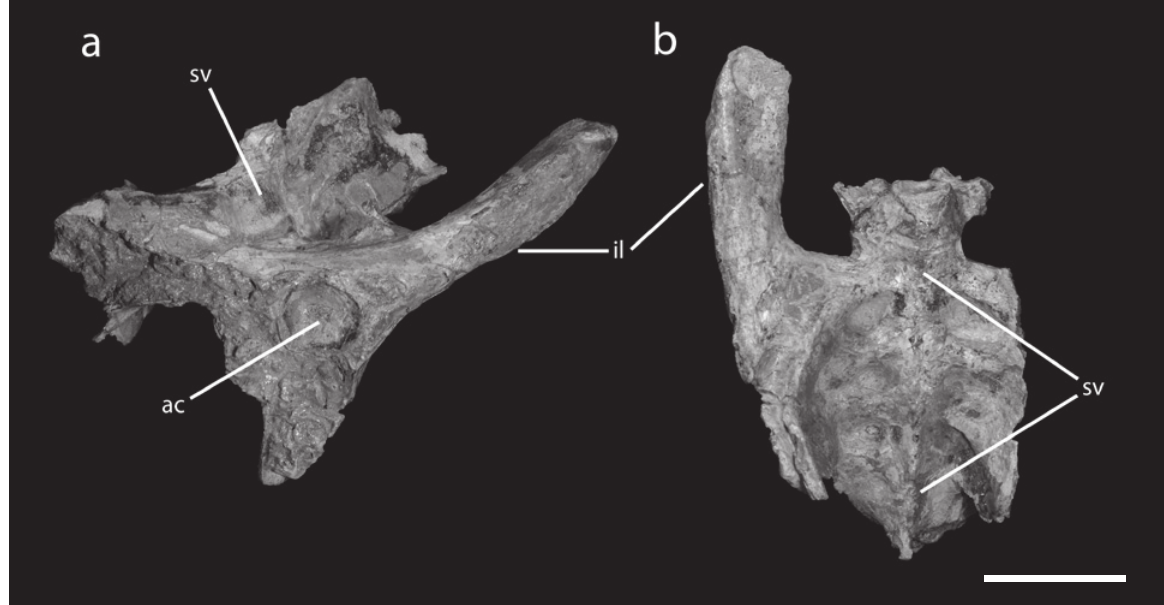
Fig. 8 - Pelvis of Tropeognathus cf. T. mesembrinus (MN 6594-V). (a) Right lateral view. (b) Dorsal view. See text for abbreviations. Scale bar 50 mm.